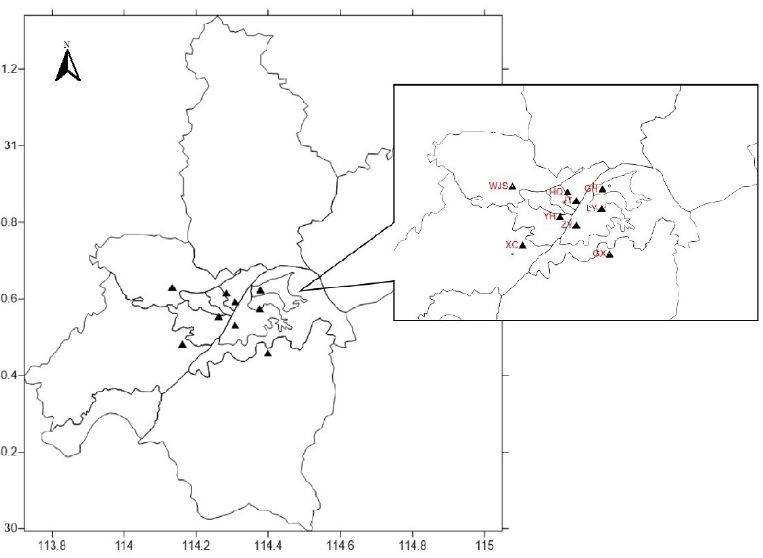
Figure 1. Location of the nine monitoring stations in urban Wuhan.